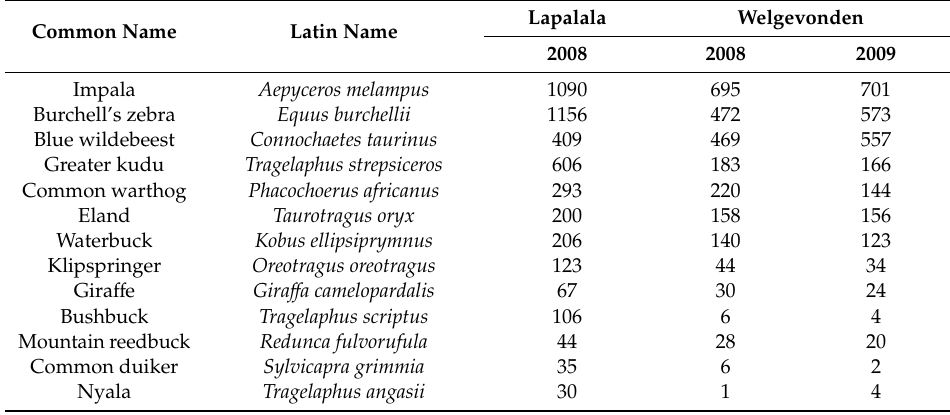
Table A1. Number of animals observed during aerial game counts in Lapalala and Welgevonden. The game counts were carried out from helicopters in September 2008 and 2009 (only